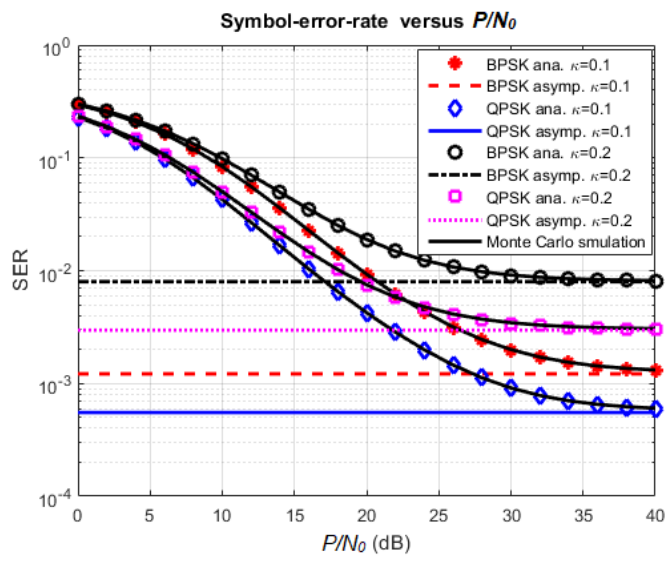
Figure 9. Effect of κ and modulation scheme on SER.